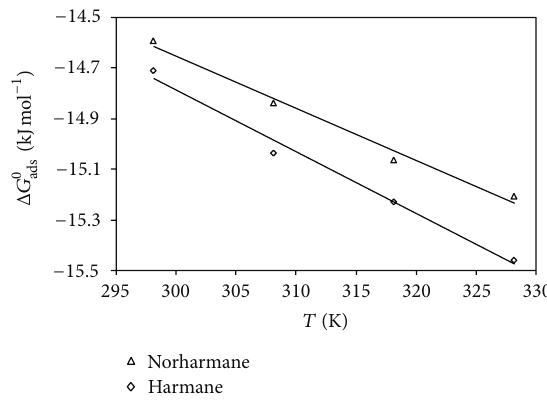
Figure 19: Variation of Δ𝐺 0 , evaluated from LP, versus 𝑇 on C38 ads steel in 1M HCl containing indole